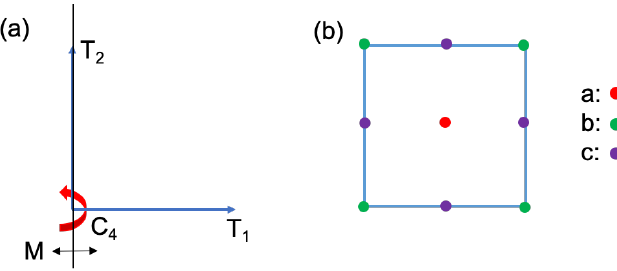
Figure 3: Panel (a) shows the generators of the wallpaper group p 4 m . In panel (b), the square is a translation unit cell of the wallpaper group p 4 m . It has three IWP, usually labelled by a , b and c in crystallography. Type- a and type- b both form a square lattice. The C rotation center in panel (a) is taken to be at the type- a 4